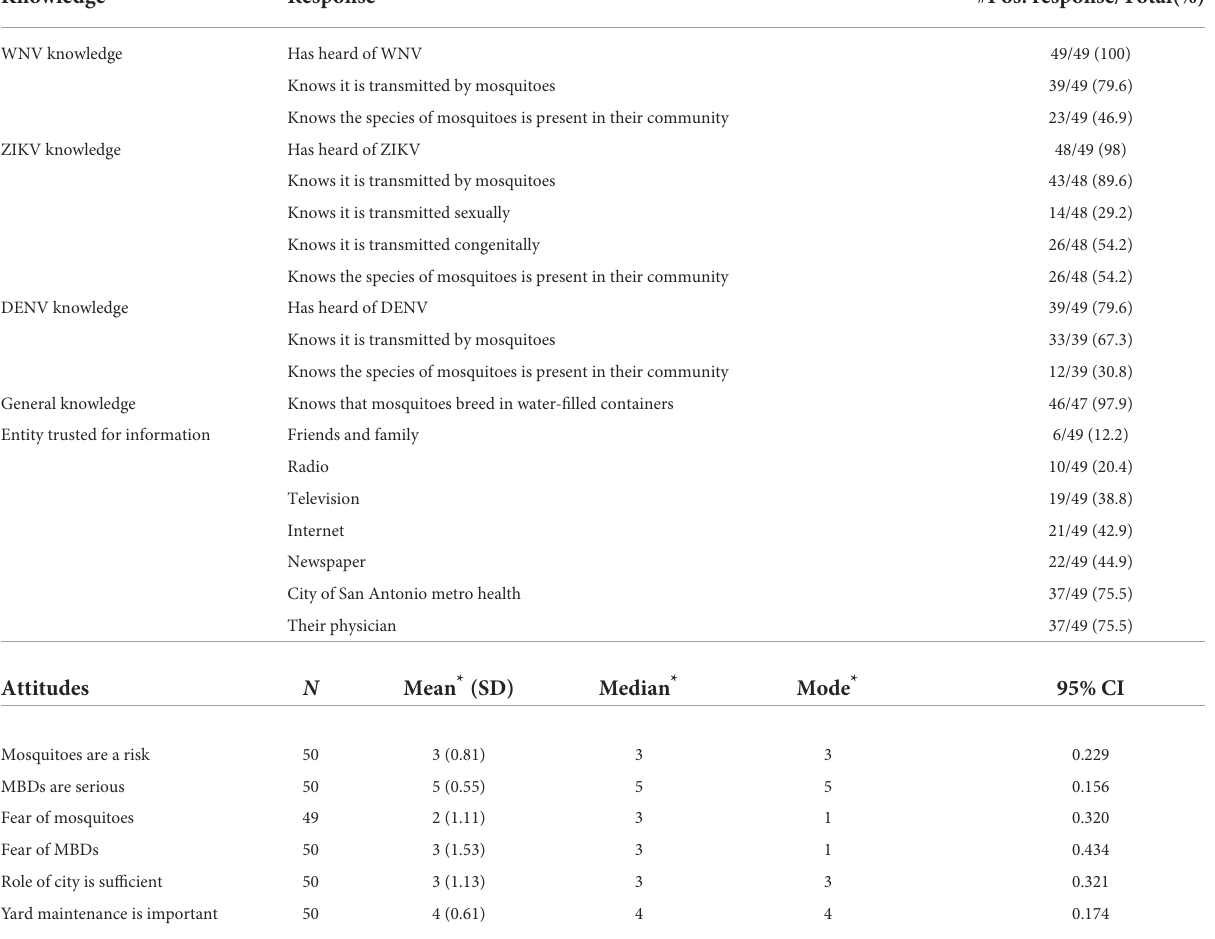
TABLE 4 Knowledge and attitudes of San Antonio community participants as they relate to